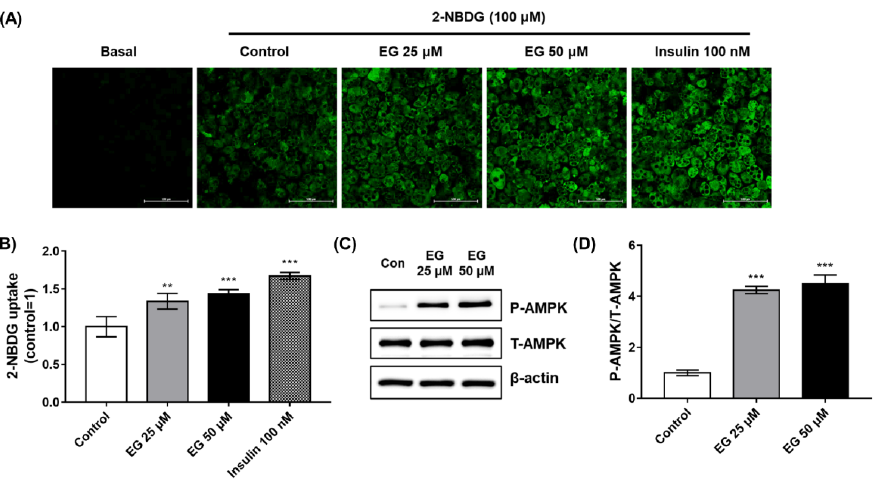
Figure 6. Ethyl gallate (EG) treatment upregulates glucose uptake and activates AMPK in 3T3-L1 adipocytes. Preadipocytes of 3T3-L1 cells were differentiated by DMI-induction (DMI: dexamethasone, methylisobutylxanthine, and insulin) for 6 days. Fully differentiated 3T3-L1 cells were incubated overnight with low-glucose Dulbecco’s modified Eagle’s medium (DMEM) for starvation, followed by treatment of EG (6 h) or insulin (30 min) in glucose-depleted DMEM with 0.1% DMSO. Subsequently, they were treated using 100 µ M 2-NBDG for 1 h. Fluorescence intensity was detected at Ex/Em = 485/535 nm by confocal microscopy ( A ) or microplate reader ( B ) after washing with cold DPBS. Scale bar, 100 µ m. For Western blot analysis, cells were lysed and analyzed after treatment of EG under the same condition as the 2-NBDG uptake assay. Western blotting was performed using anti-P-AMPK, T-AMPK, and β -actin antibodies ( C ). Quantification was performed for P-AMPK, T-AMPK, and normalized to control using CSAnalyzer 4 ( D ). Data are shown as mean ± standard deviation ( n = 3 or 4). ** p < 0.01. *** p < 0.001. Statistical significance was analyzed by one-way ANOVA for multiple comparisons followed by Tukey–Kramer statistical